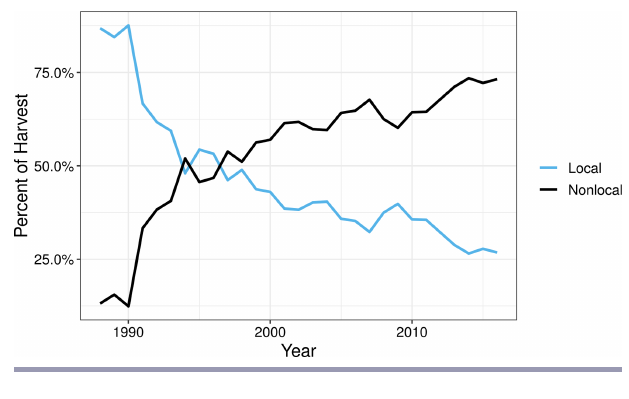
Fig. 3 . Local and nonlocal subsistence salmon harvest levels for Glennallen subdistrict (as percentage of harvest).